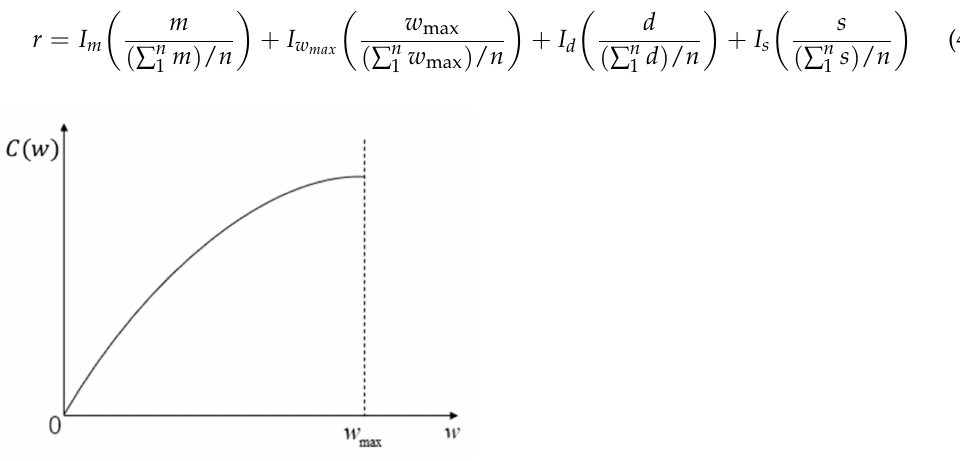
Figure 2. The curve of the upgraded non-linear